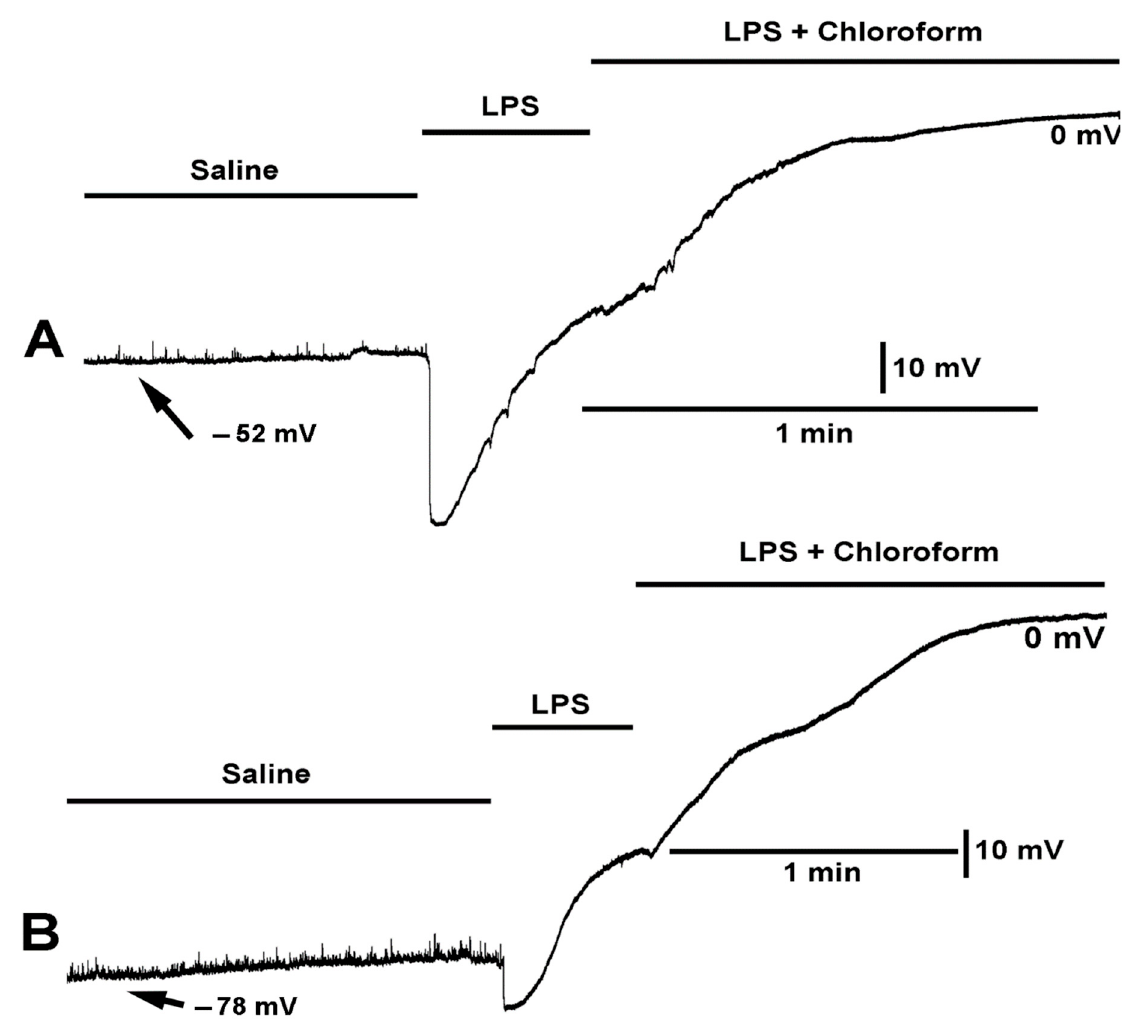
Figure 6. The effect on the resting membrane potential by LPS and LPS combined with chloroform (0.2%). ( A , B ) Two different preparations are shown with the same mixtures of compounds. LPS produced a larger hyperpolarization in preparation shown in ( A ) than in the preparation shown in ( B ). Upon exposure of LPS combined with chloroform the membrane potential continued to depolarize to zero.